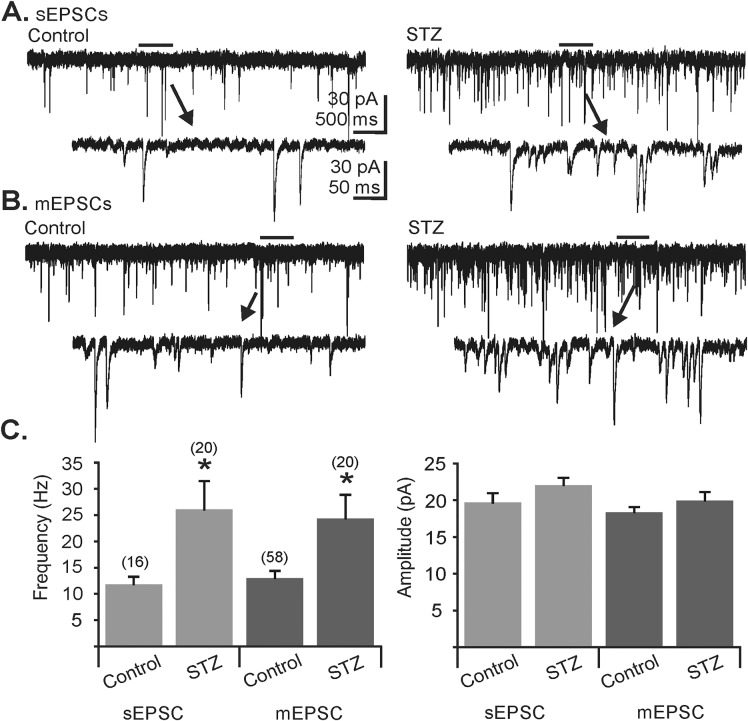
Comparison of sEPSCs and mEPSCs in dorsal motor nucleus of the vagus (DMV) neurons from control and STZ-treated, hyperglycemic mice.
A. Representative traces showing sEPSCs in DMV cells from control (left) and hyperglycemic (STZ; right) mice. B. Representative traces of mEPSCs in neurons from control (left) and hyperglycemic (STZ; right) mice. Arrows point to expanded sections of traces indicated in A and B; picrotoxin (100 μM) was present in all recordings. C. Group frequency and amplitude graphs for sEPSCs and mEPSCs in control and hyperglycemic (STZ) mice (asterisk indicates significant difference from control; p<0.05; Mann-Whitney U test; numbers of replicates are indicated above each bar).